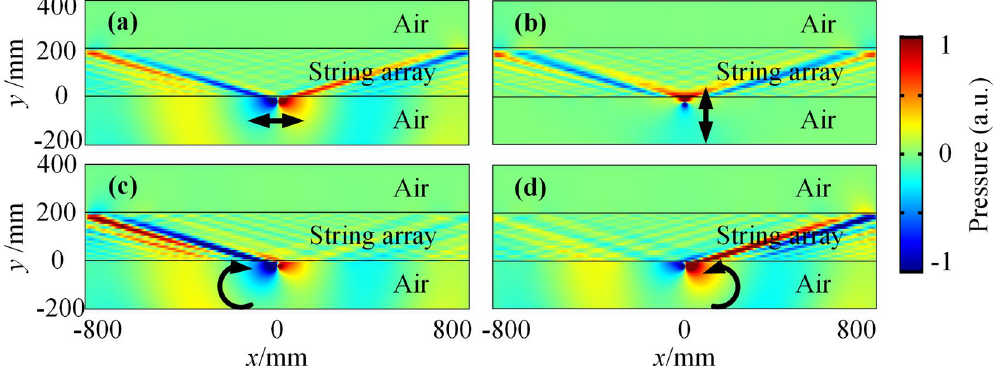
Figure 3. ASHE in the string-type AHMM. The pressure field excited by (a) the acoustic horizontal dipole = p [1, 0] , (b) the acoustic vertical dipole p [0, 1] = , (c) the acoustic clockwise helical wave emitter = p i [1, ] and (d) the acoustic counterclockwise helical wave emitter = − p i [1, ] situated in the near-field of the string-type AHMM (See Supplementary Movie 2).